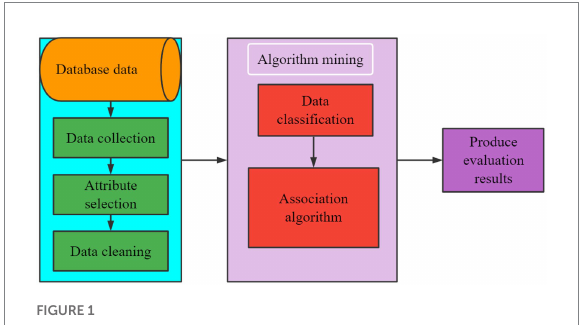
FIGURE 1 Data mining process of CSMH